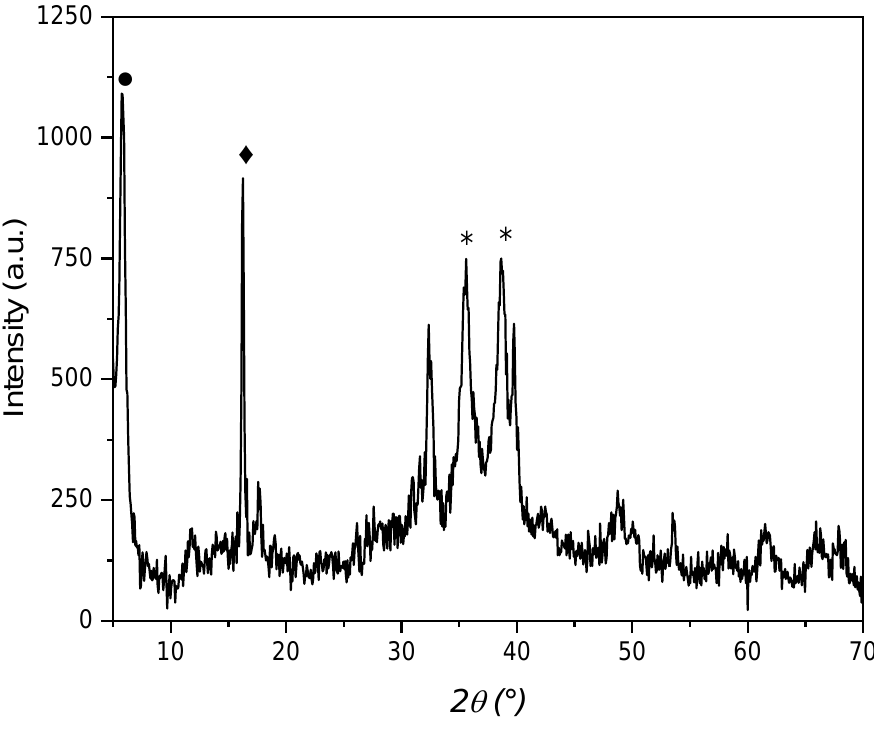
Figure 7. X-ray diffraction pattern of copper hydroxy acetate after the third recycle test.